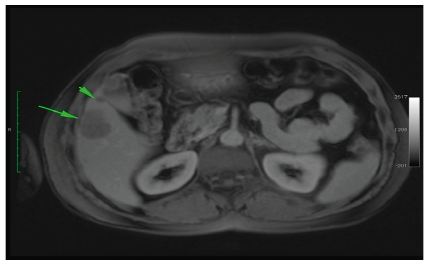
Figure 2: T1-weighted gradient-echo contrast-enhanced image. Two lesions are seen in the right liver lobe adjacent to the gallbladder.